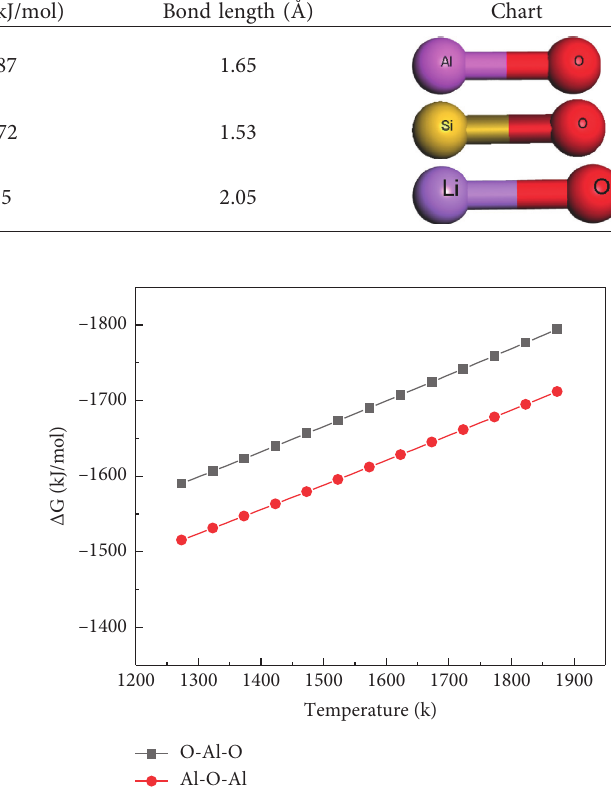
Figure 3: The change in ∆ G of different structures with respect to